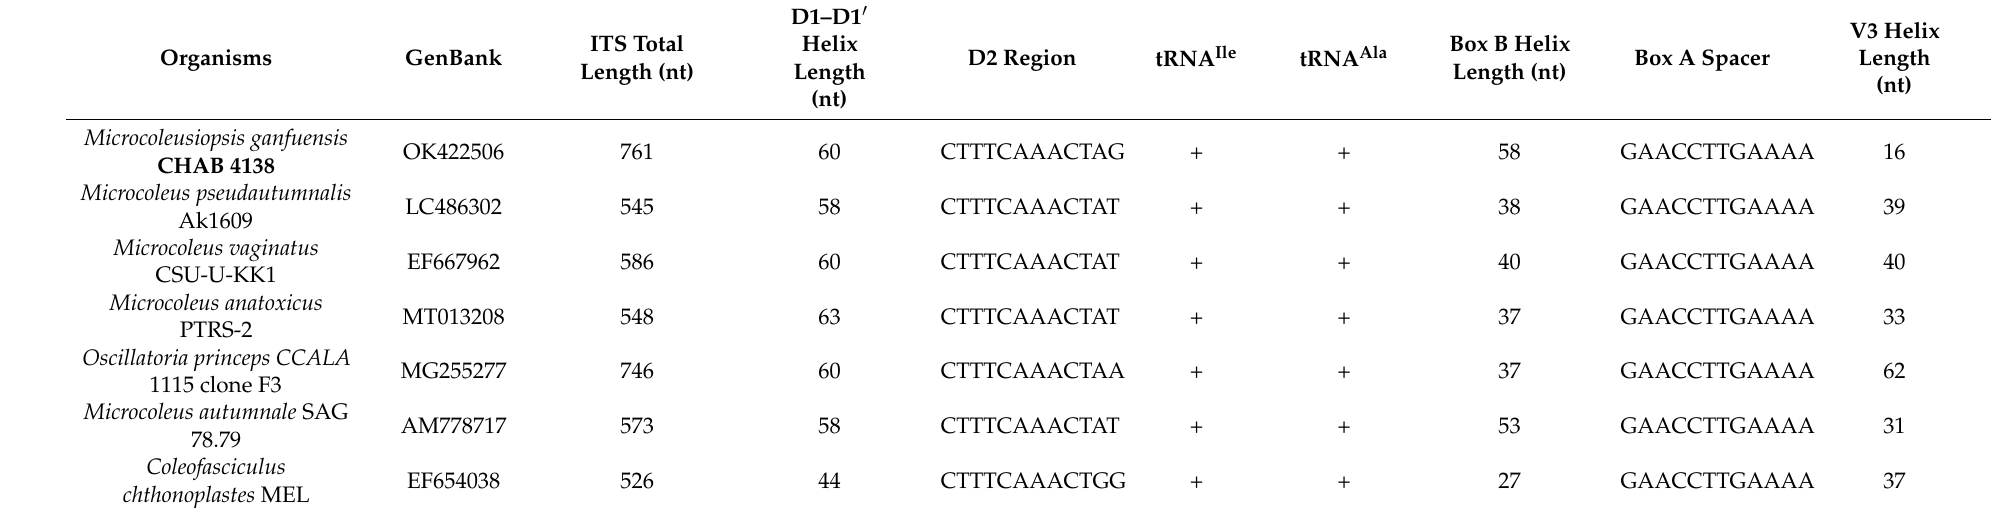
Table 2. Analyses on ITS of 16S–23S region for Microcoleusiopsis ganfuensis